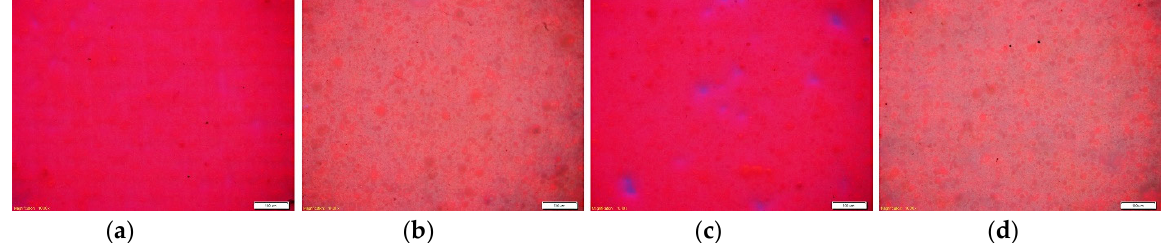
0.5% TiO 2 —aged for 12 h; ( c ) FC + 1.5% TiO 2 —unaged sample; ( d ) FC + 1.5% TiO 2 —aged for 12 h.